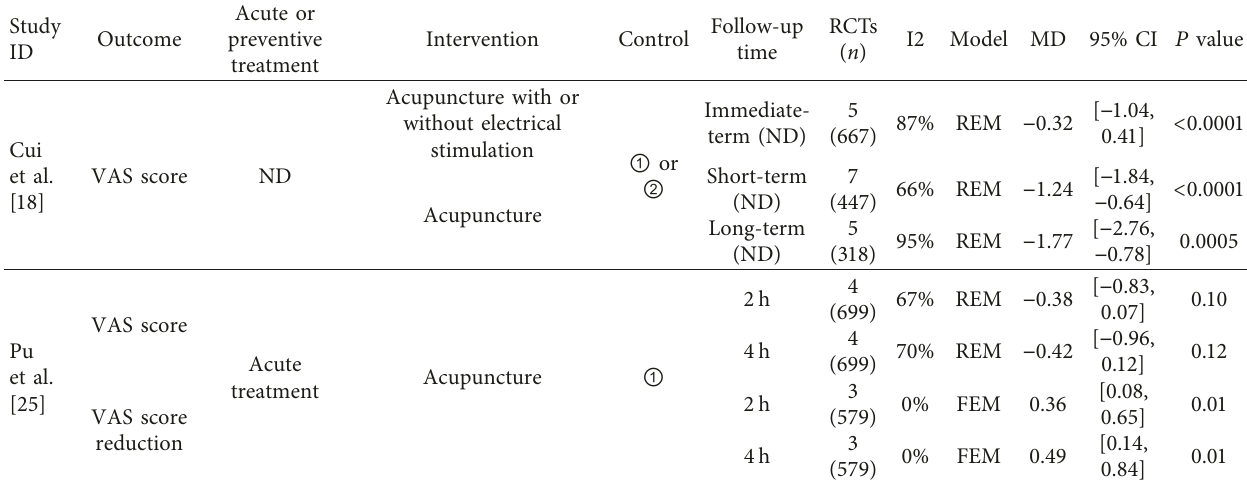
Table 4: MAs outcomes about VAS